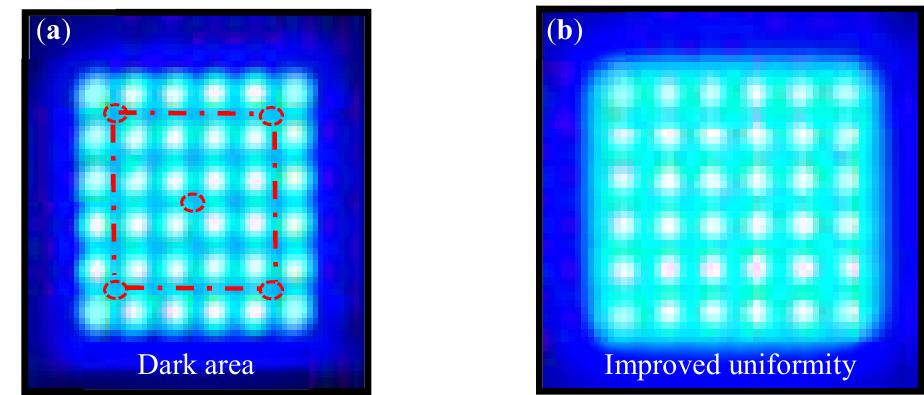
Figure 14. Samples of the light guide layer unit module: ( a ) without PSMLAs; ( b ) with concave PSMLAs. Figure 15 plots the measured plane rectangular light distribution curves of the light guide layer unit module that was combined with a diffusion film. Figure 15a presents the results for the diffusion film that was combined with the light guide layer unit module without concave PSMLAs for which the FWHM of the light angle was 113 ◦ . Figure 15b shows the curve of the light guide layer unit module that was combined with a concave PSMLA structure and a diffusion film, with the FWHM of the light angle increased to 130 ◦ . The results indicate that after the adjustment of the microstructure, the light source energy concentrated in the center diffused, and the distribution range of the light emitted by the mini-LEDs could be